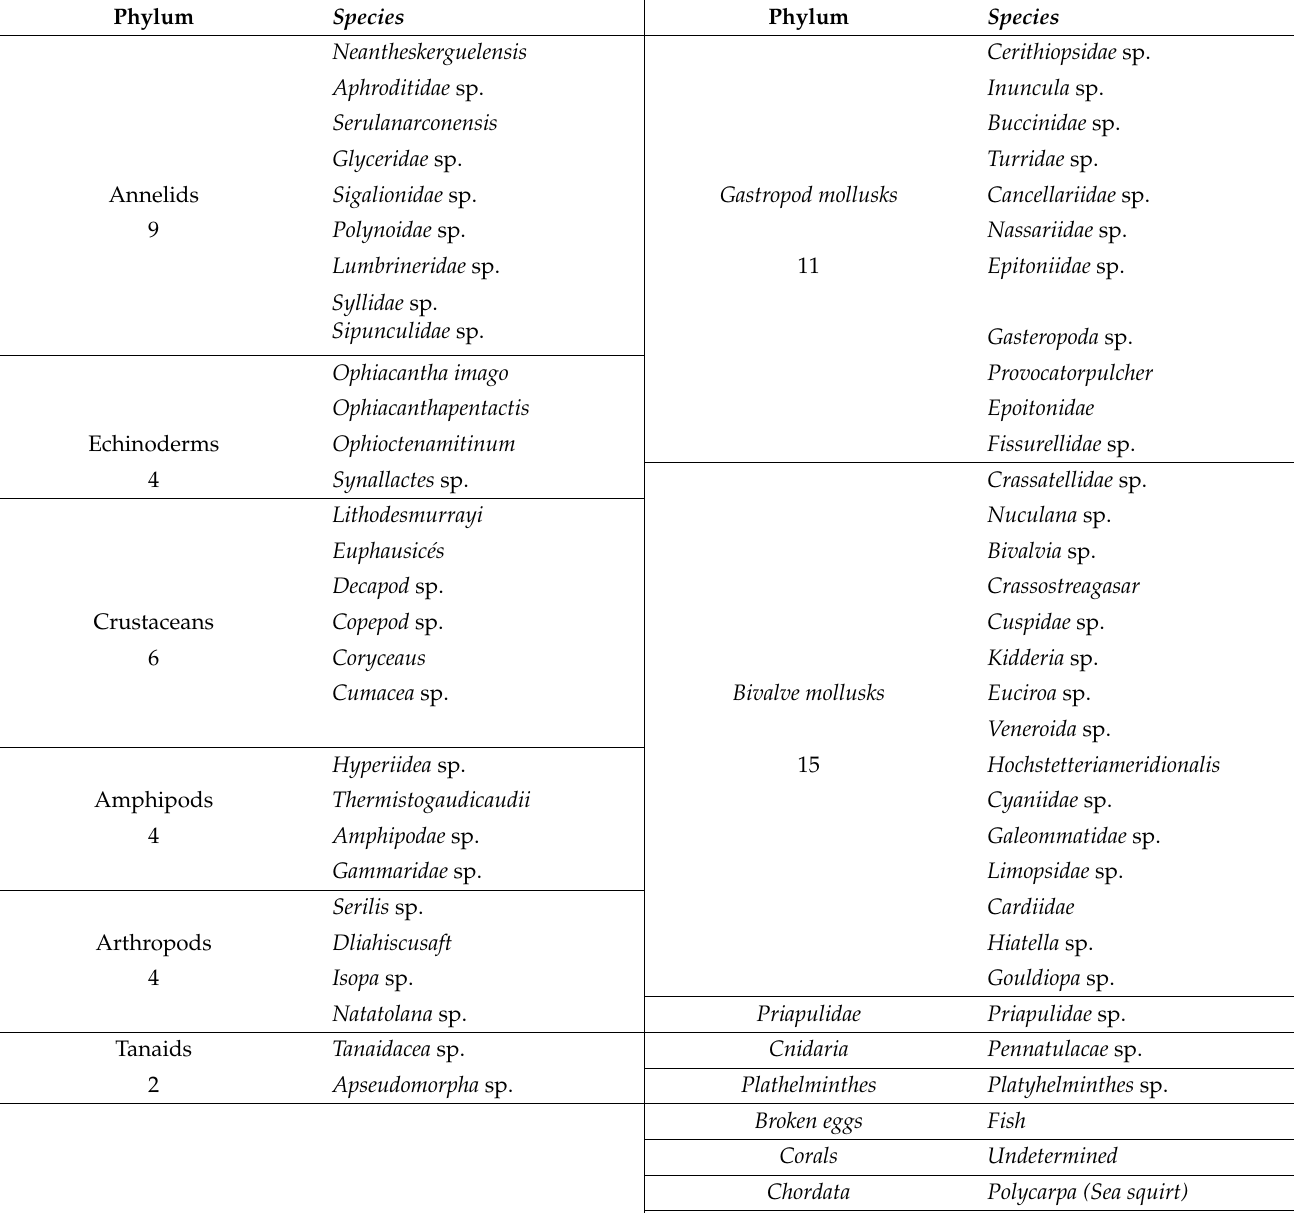
Table 2. List of benthic species sampled in thirteen sampling stations along the road channel from the mouth of the Casamance estuary to